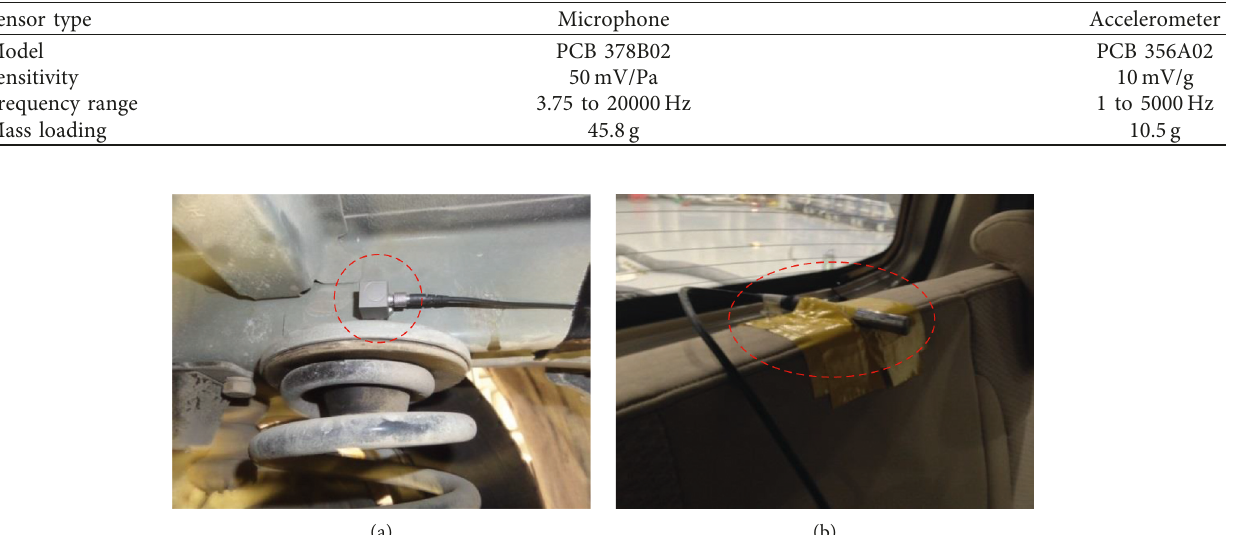
Table 1: Sensors used in the TPA test.